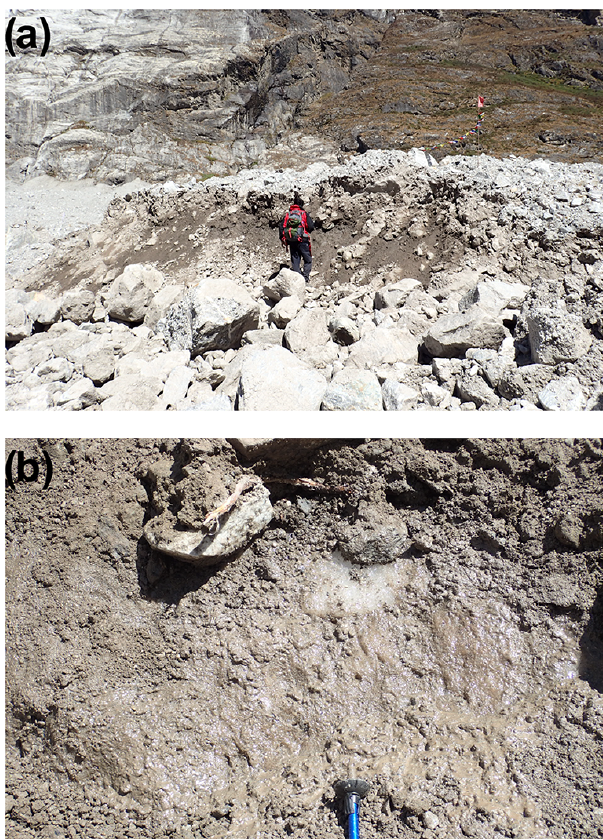
Figure 9. (a) A image of the avalanche-induced sediment surface taken in an in situ survey carried out by Fujita et al. (2017). (b) A close-up image showing exposed and melting ice (date: 21 Octo- ber